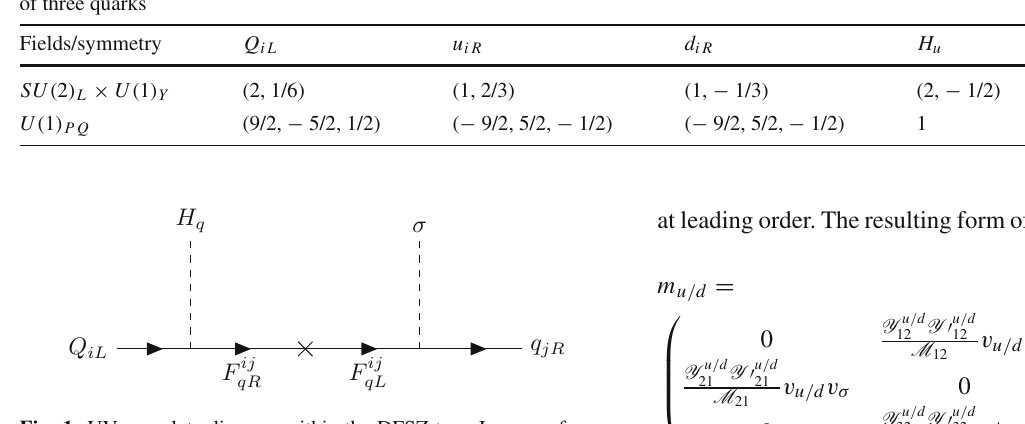
Fig. 1 UV complete diagram within the DFSZ type-I seesaw frame- work as apparent from Eqs. (6) and